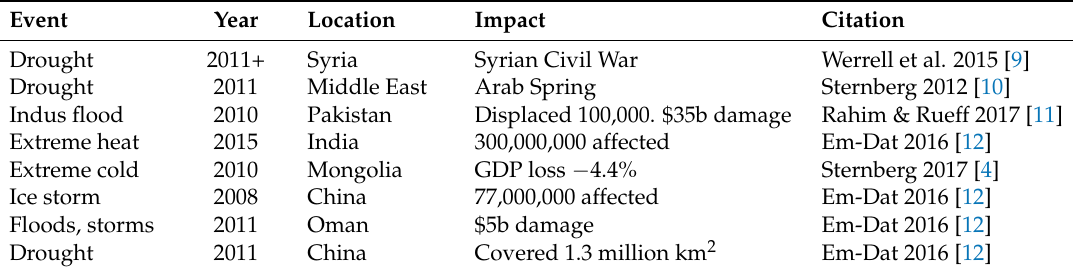
Table 1. Recent Asian desert and dryland disasters.